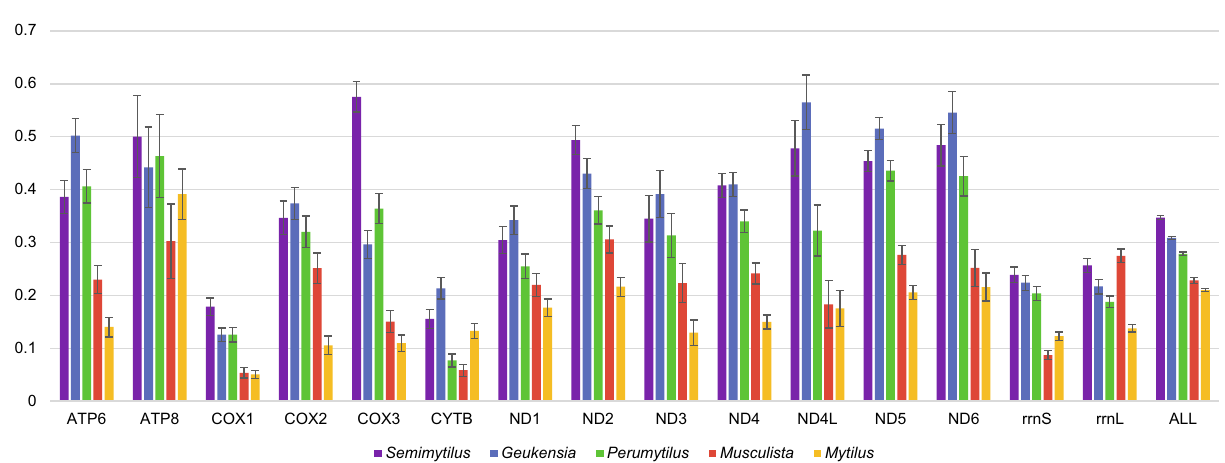
Figure 1. Genetic map of Semimytilus algosus mitochondrial genomes. The white arrows represent protein coding genes with predicted transmembrane domains of encoded proteins marked in orange. The long dark arrows represent rRNA genes; the short dark arrows represent tRNA labeled by a one letter amino acid code, short white arrows represent duplicated tRNA-like structures, a pink box indicates the location of an AT-rich region; a grey box indicates the location of repetitive sequences; blue lines in front of the genes show the location of the polyadenylation signal. Inner circles represent local compositional bias, calculated in a 200 bp long sliding window with 25 bp steps, unless indicated otherwise. A green outer circle represents a AT-skew (A−T/A+T); a red line represents a filtered AT ‐ skew, calculated at non-coding regions and the second codon position only. A black line represents a filtered AT-skew, calculated at neutral and non-coding positions only, in a larger, 1000 bp long window. A middle blue circle represents a GC skew (G−C/G+C), and a green line represents a GC skew at neutral sites, calculated in a window of 1,000 bp. Both skew indices are presented in absolute scale, starting at zero. An inner red circle represents local GC content, and a green line shows GC content at neutral sites. Local GC content is presented in scale relative to the average for the whole mitogenome.